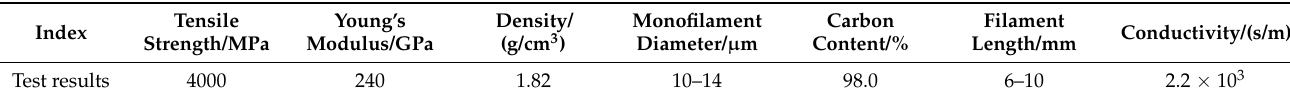
Table 6. The main properties of carbon fiber.